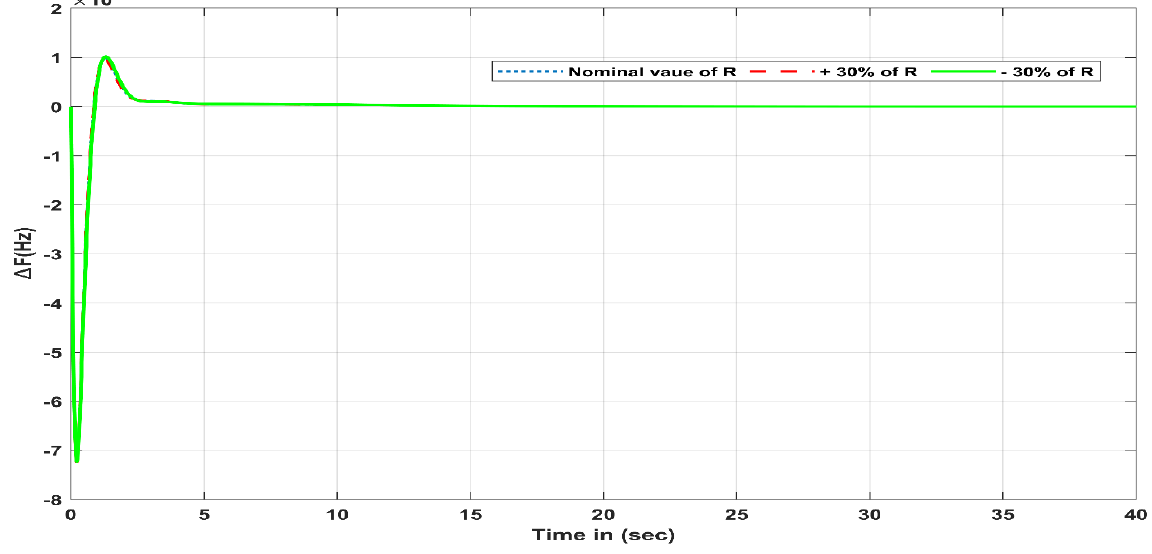
Figure 10. Parametric variation in R. Table 4. Sensitivity analysis for changes in parameters of the power system with various perfor- mance indices.